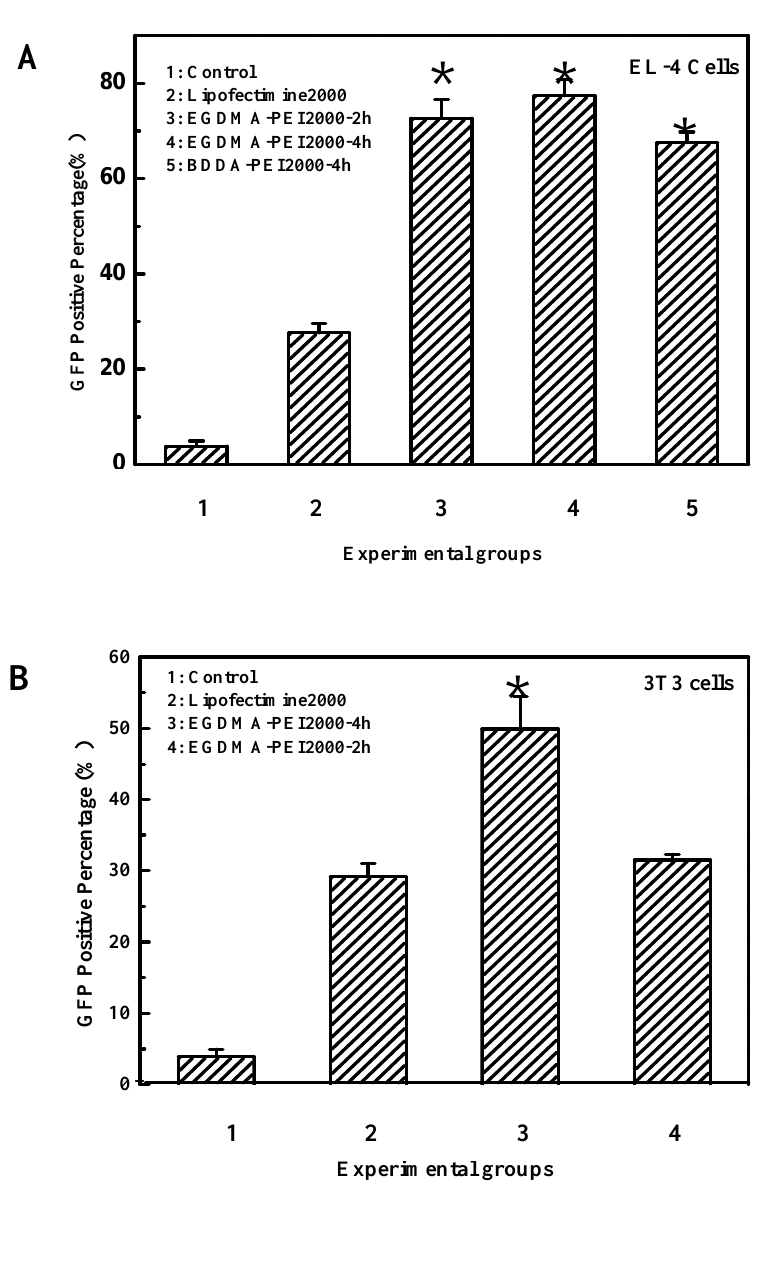
Figure 9. Comparison between cross-linked polymers and Lipofectimine2000 for gene delivery in EL- 4 and 3T3 cells .Cells were transfected using optimal conditions established for each polymer. Control: PBS only, no plasmid, no polymer. (A) *, p < 0.01 ， as compared to Lipofectamine 2000. (B) *, p < 0.01 ， as compared to Lipofectamine 2000 and EGDMA-PEI2000-2h. N= 6, error bars represent standard